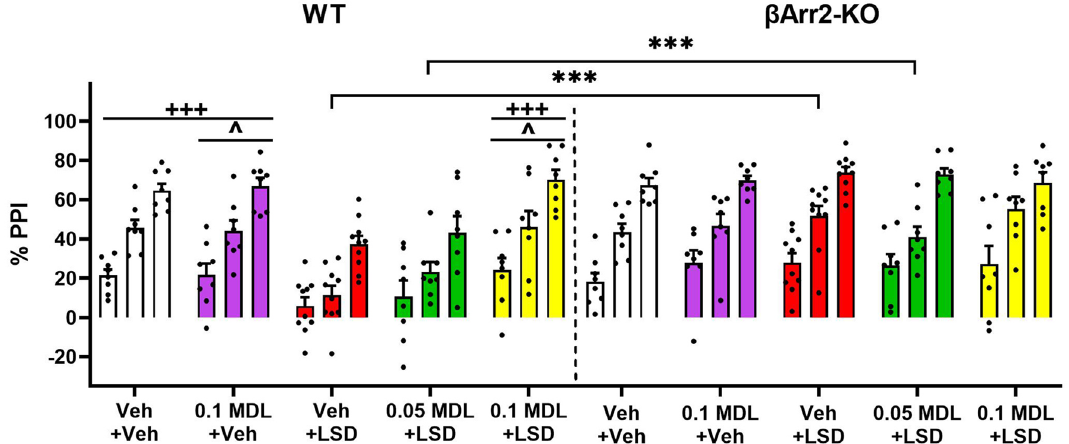
Figure 6. Effects of LSD and MDL100907 on prepulse inhibition in β-arrestin 2 mice. A description of the experimental design is provided in the Fig. 5 legend. PPI in WT and βArr2-KO mice treated with MDL or LSD. A RMANOVA found the main effects of prepulse intensity [F(1,74) = 580.044, p < 0.001], genotype [F(1,74) = 18.823, p < 0.001], and treatment [F(4,74) = 3.953, p = 0.006] to be significant; the genotype by treatment interaction [F(4,74) = 5.660, p < 0.001] was also significant. N = 8–10 mice/group. *** p < 0.05, WT vs. KO; +++ p < 0.001, LSD vs. indicated groups within genotype; ^ p < 0.05, 0.05MDL + LSD versus indicated groups within